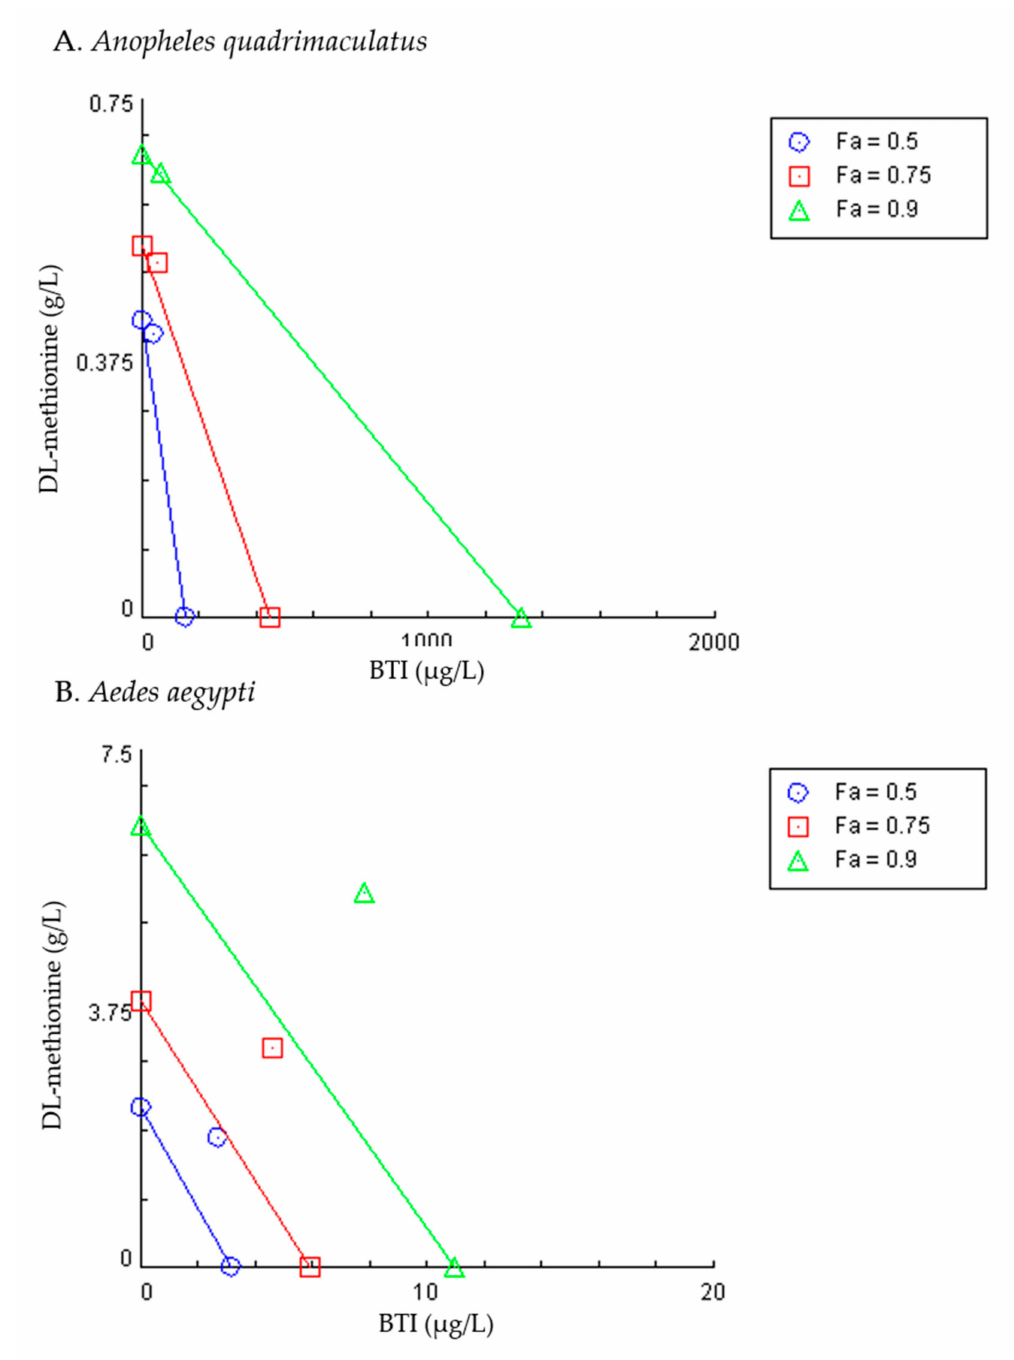
Figure 5. Isobolograms for Anopheles quadrimaculatus (( A ), n = 4) and Aedes aegypti (( B ), n = 6) for DL-methionine and Bacillus thuringiensis subspecies israelensis (BTI) alone and in combination exposed for 48 h in glass jars. Each line and set of symbols represent the lethality fraction ( f a ) a ff ected by the concentration. The concentration of DL-methionine on the y-axis and BTI on the x-axis. A line is drawn between the LC 50 of each active ingredient on its respective axis. The position of the data point for the combined treatment (data point not on either axis) indicates synergistic (below the line), additive (on the line) or antagonistic (above the line) e ff ects. Plotted using the software Compusyn [30]. In contrast, a complementary relationship was not detected at the concentrations tested when the combination of DL-methionine and BTI was used against Ae. aegypti . At all concentrations